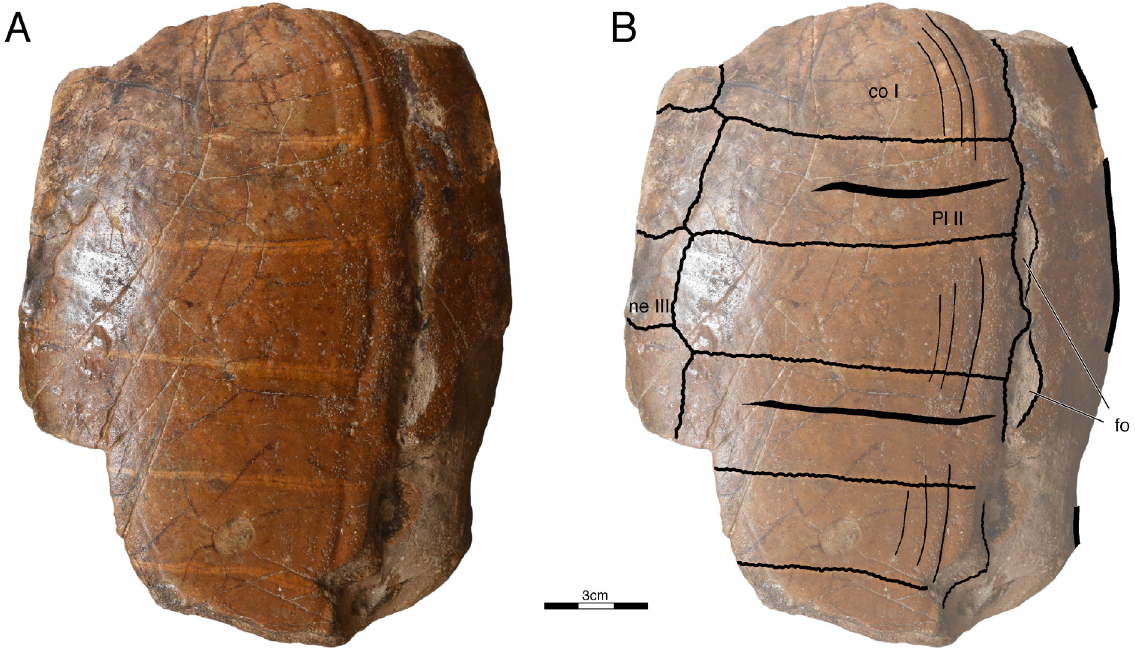
Fig. 5. BMNH R.603, referred to Hardella thurgi (Gray, 1831) by Lydekker (1889b), here identified as Palatochelydia indet. A . Photograph of right carapace side. B . Illustration of right carapace side. Scale bar: 3